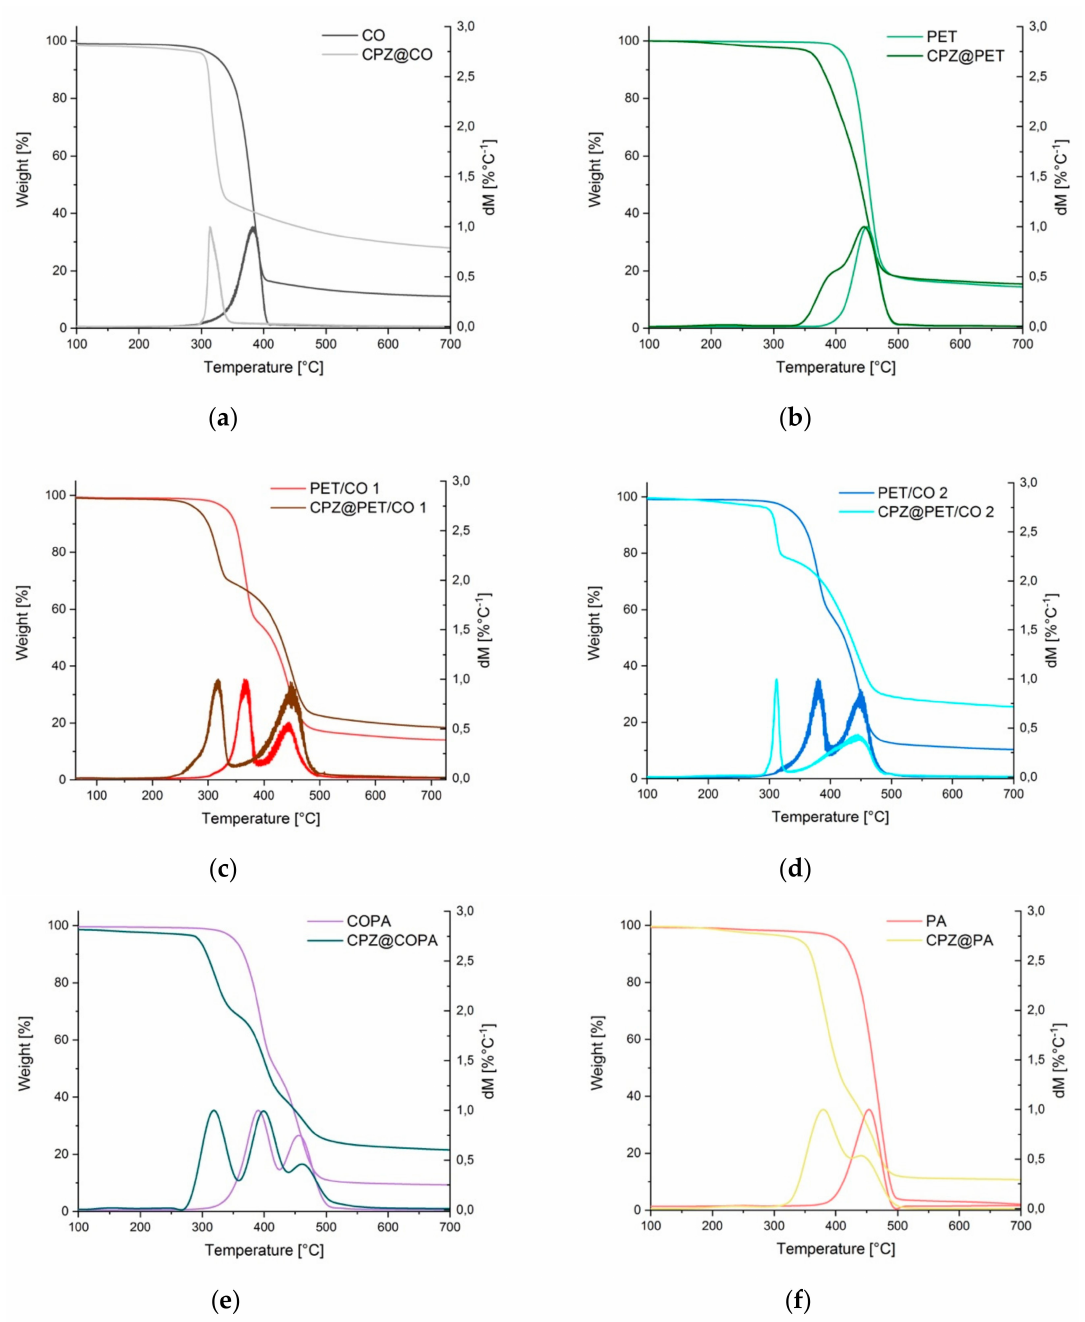
Figure 4. TGA and derived TGA thermograms of native textile and CPZ finished textiles measured under N 2 , where ( a ) CO; ( b ) PET; ( c ) PET / CO 1; ( d ) PET / CO 2; ( e ) COPA and, ( f ) PA 6.6. The add-on value for all samples is around 10